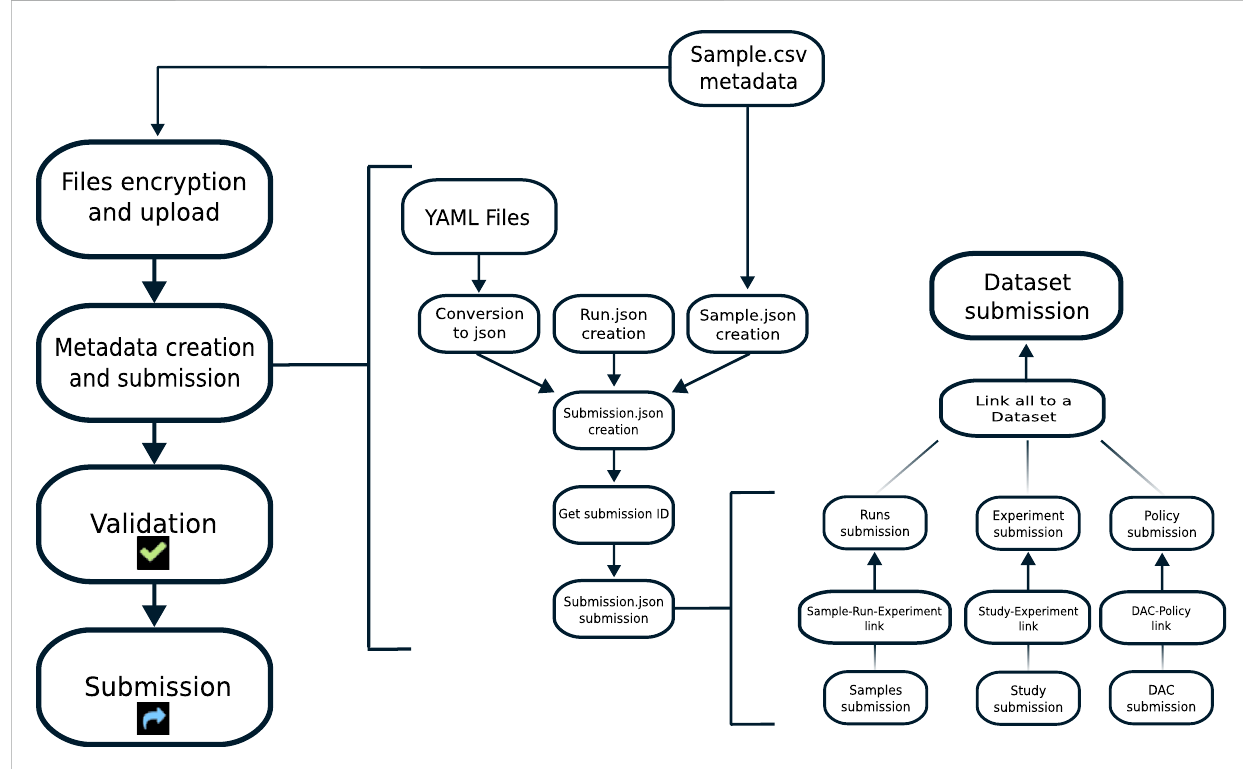
FIGURE 1 Work fl owofthepipeline.Left:themainstepsareshown.ThetoolencryptsanduploadstotheEGAboxallthe fi leslistedbytheuser.Middle:starting from YAML fi les and the CSV fi le fi lled in by the user, EGA entities are created. Right: all the needed entities are linked, following the required data model, and submitted. At the end of the process, entities are validated by EGA and the submission process is